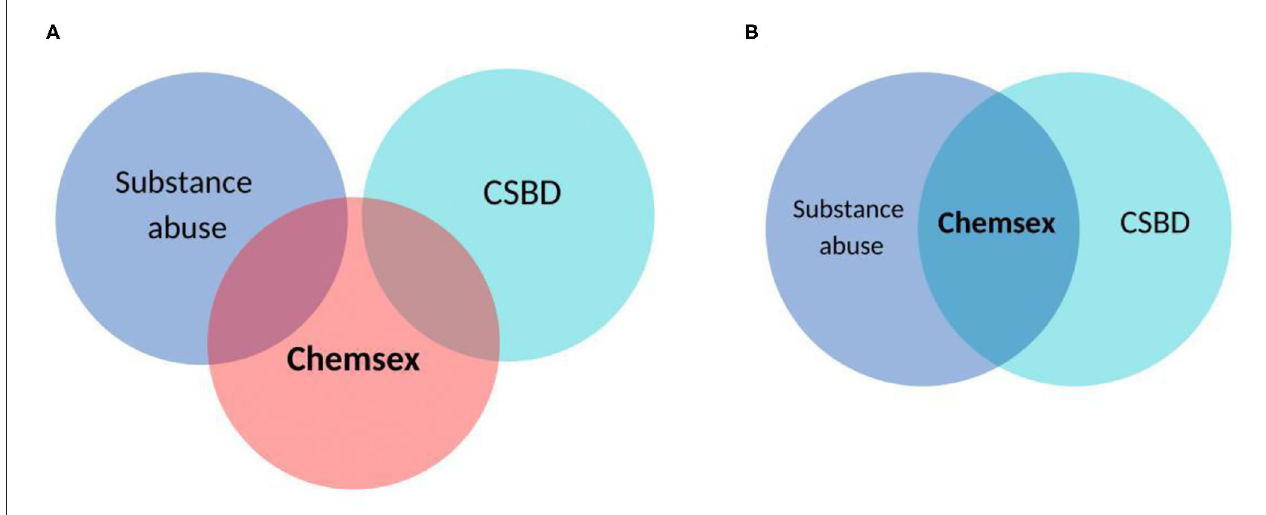
FIGURE 1 | The presentation of chemsex as a separate entity (A) and as conjunction of substance use disorder and compulsive sexual behavior disorder (B)